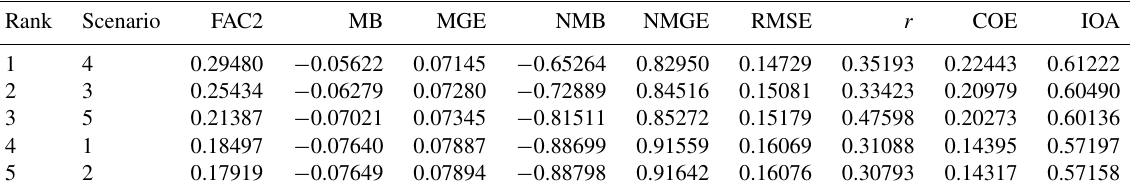
Table 4. Comparison between modelled and measured BaP concentrations for the entire 2006 EMEP dataset ( n = 173) along with perfor- mance metrics and ranking across all sites.